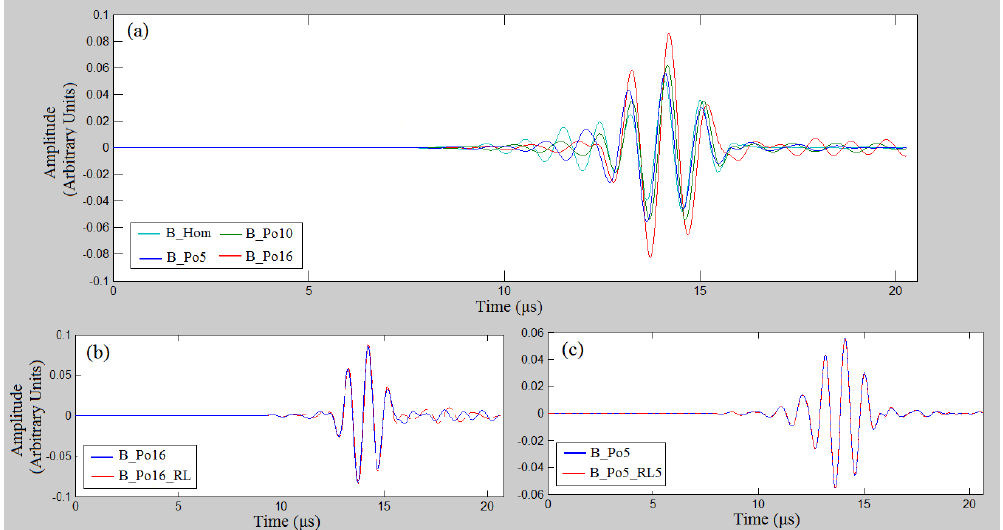
Figure 7. Waveforms derived from receiver R8 for the excitation frequency 1 MHz and simulation time 20 μscomparing the examined cases: ( a )B_Hom, B_Po5, B_Po10 and B_Po16; ( b ) B_Po16 and B_Po16_RL; ( c ) B_Po5 and B_Po5_RL5.